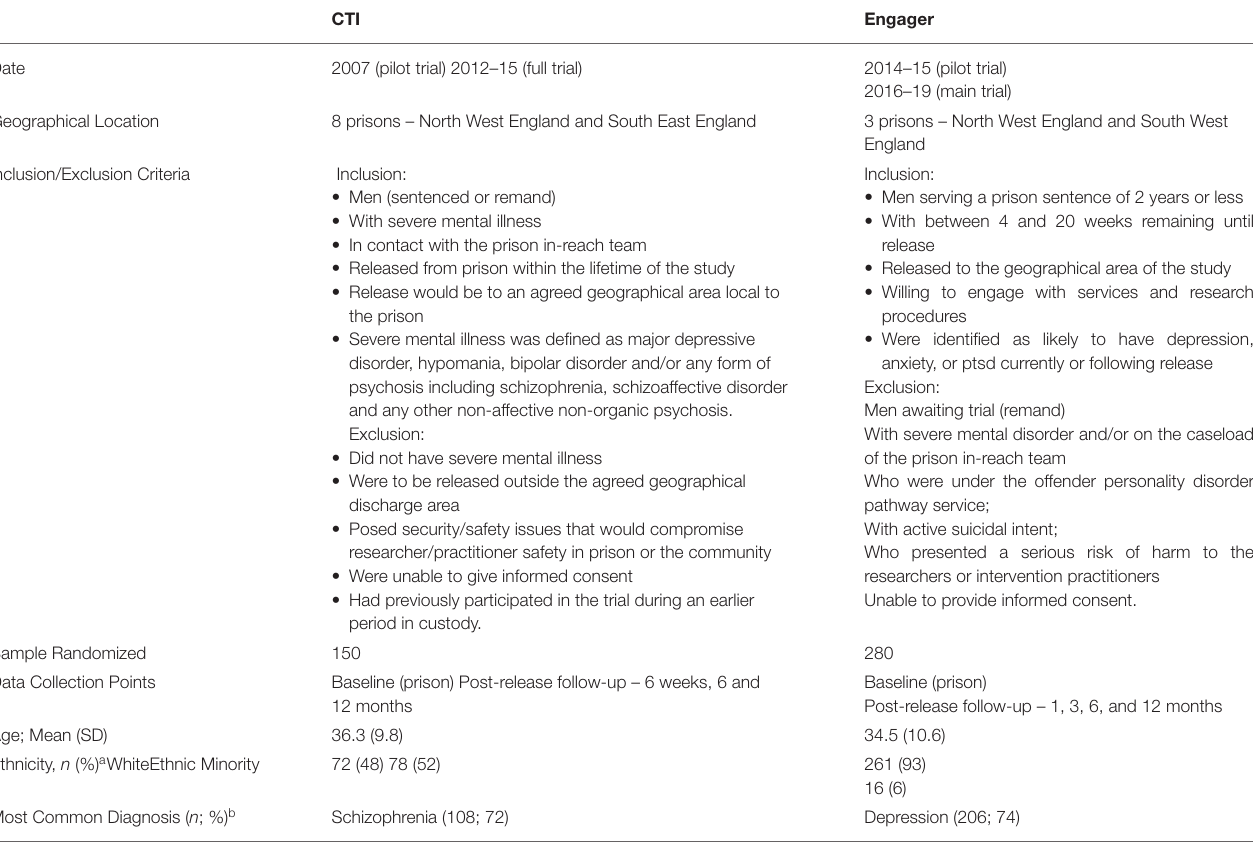
TABLE 1 | Study information for CTI and Engager.